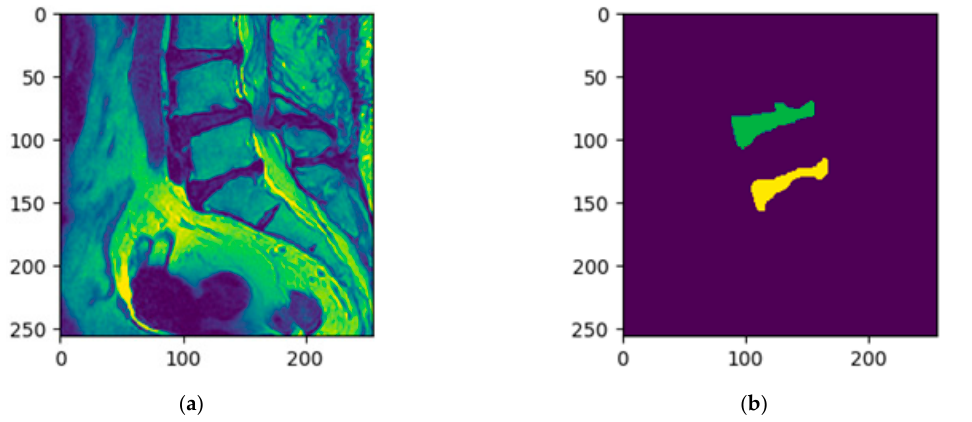
Figure 4. The cropped images that were used to train the MultiResUNet in the first stage: ( a ) the cropped original spine MRI image (shown in the viridis color maps); ( b ) the corresponding standard masks of the lower two intervertebral discs of ( a ).